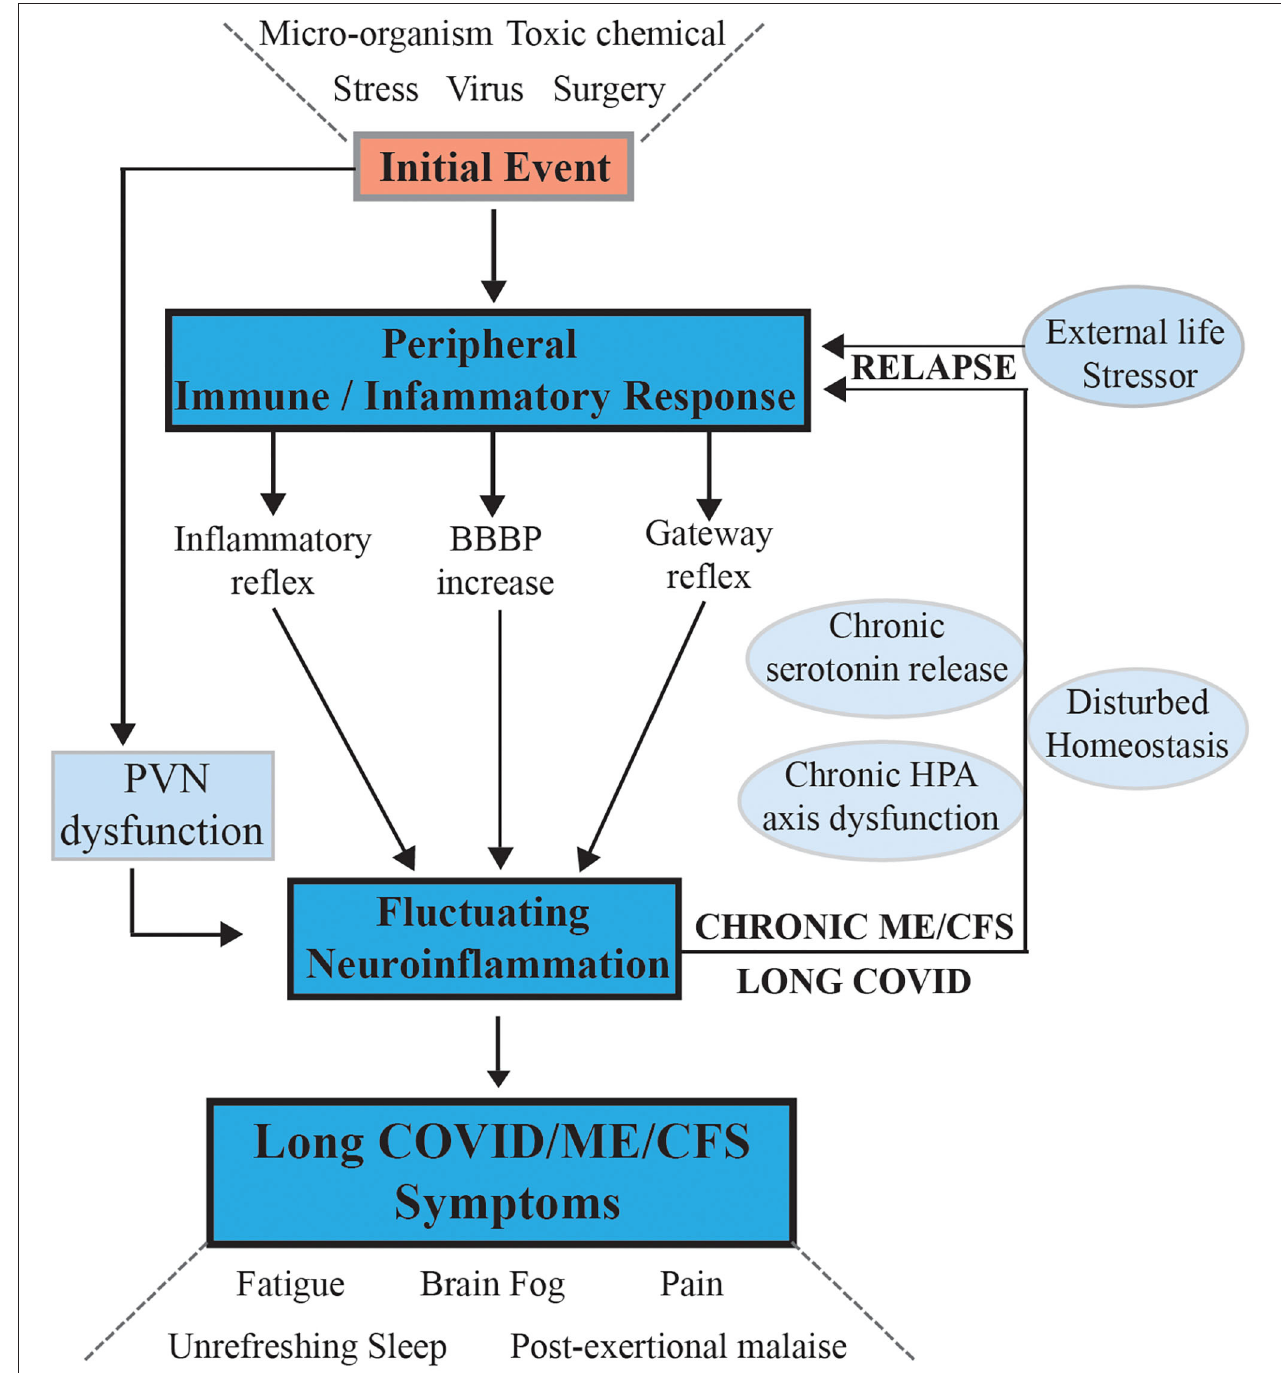
FIGURE 1 | Hypothesis and model for onset of ME/CFS and its progression to a chronic sustained illness with relapse/partial recovery phases: signaling pathways between the CNS and the periphery that maintain the illness. Following an initial external stressor event systemic immune/inflammatory responses are activated, these are communicated to the CNS via inflammatory, and gateway reflexes and possibly an increase in permeability of the BBB. Neuroinflammation is activated affecting the stress center within the PVN of the hypothalamus and leads to a wide range of neurological symptoms that feedback to the periphery via disturbance of homeostasis and the stress activated HPA axis that becomes dysfunctional with chronic activation. The systemic physiology and molecular homeostasis are then chronically affected through important cellular functions like mitochondrial energy production metabolic activity and a continuation of immune/inflammatory reactions. External life stressors that feed into a disturbed PVN not only maintain the ME/CFS but also act to precipitate relapses.